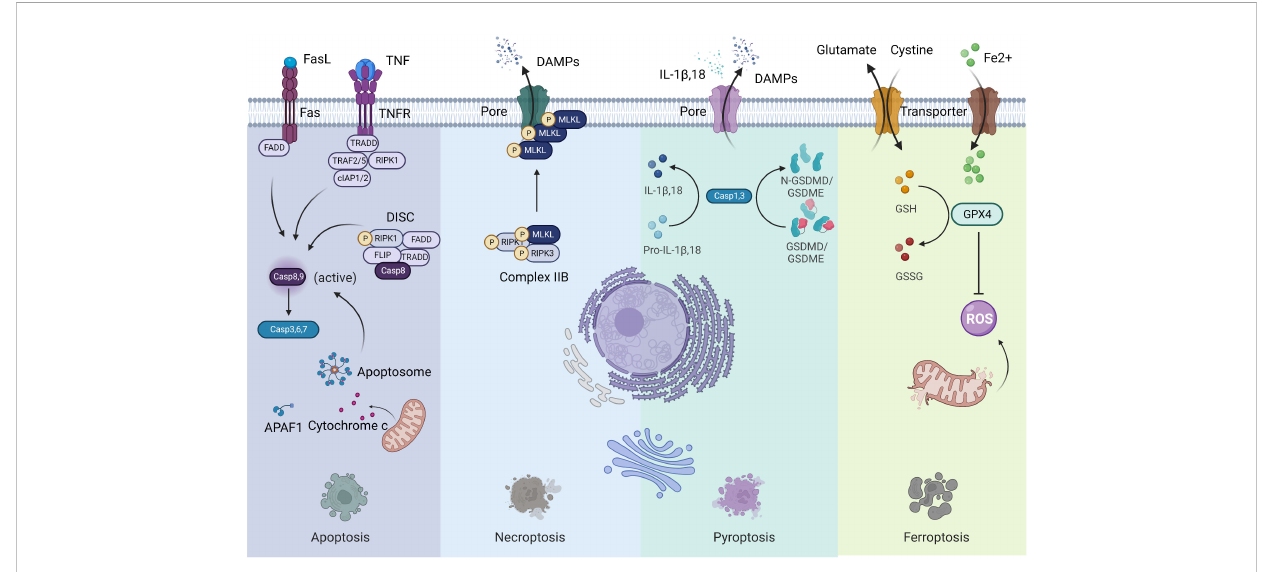
FIGURE 1 Four forms of regulated cell death. Left: Apoptosis; Middle to the left: Necroptosis; Middle to the right: Pyroptosis; Right: